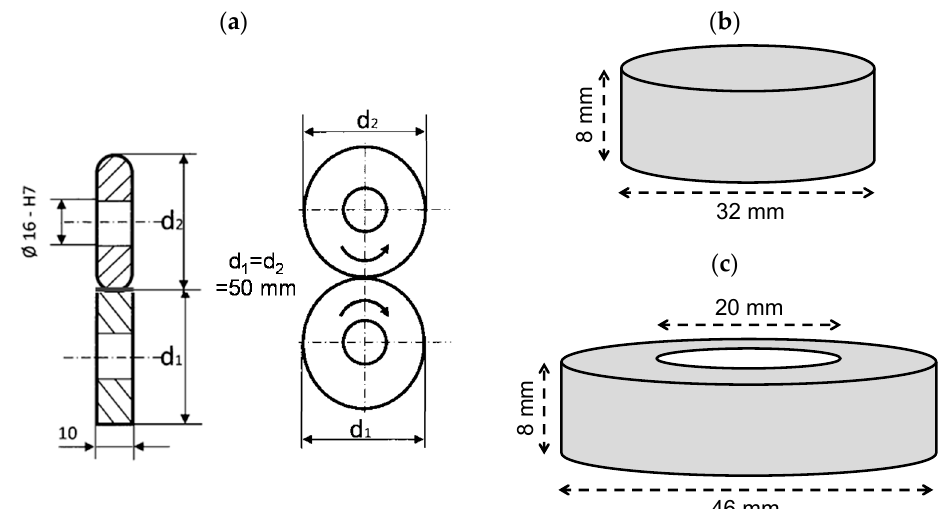
Figure 1. Geometry of the specimens for the model wear tests. ( a ) Two-disc test. ( b ) Ball-on-disc test. ( c ) Thermal fatigue test.